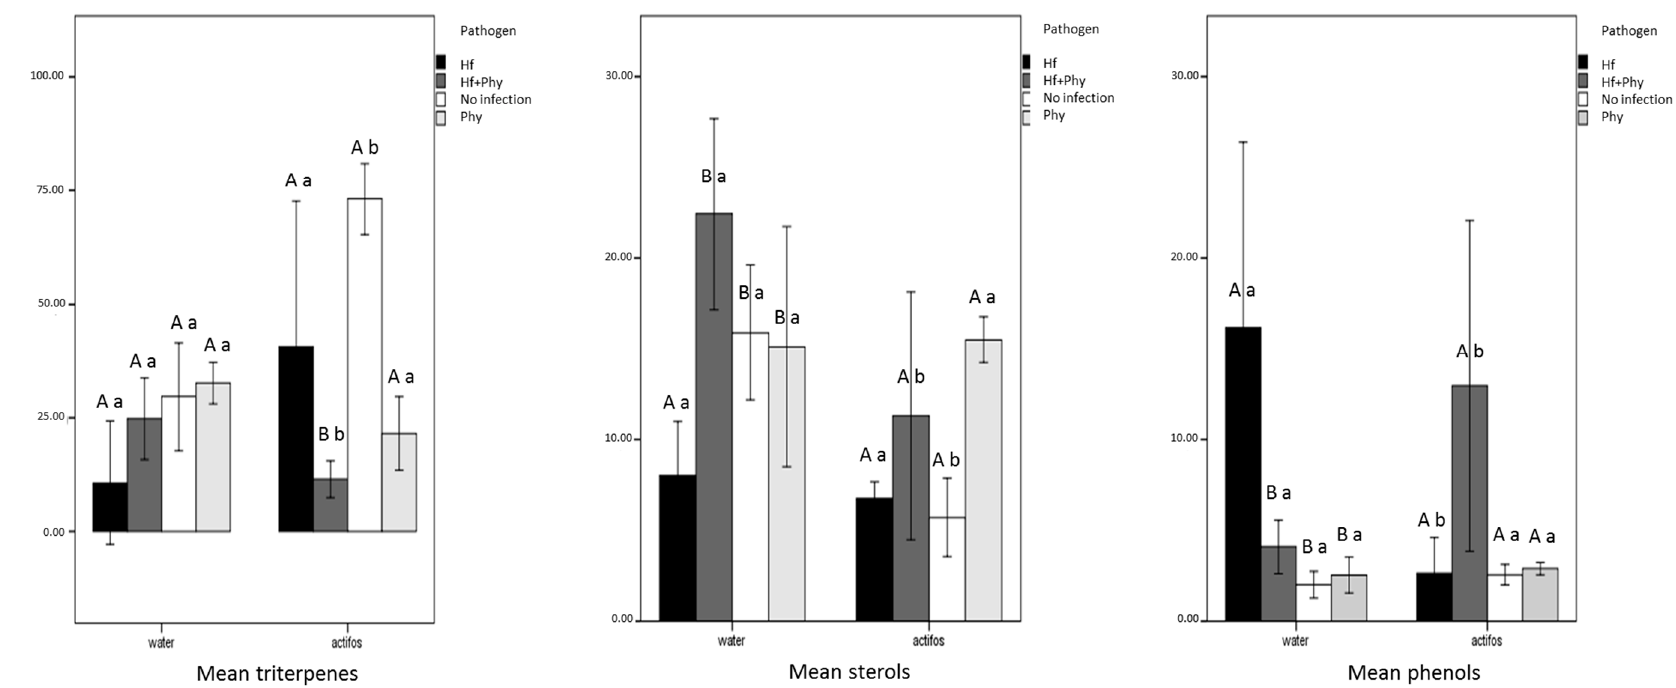
Figure 4. Content (%) of triterpenes, sterols, and phenols of cortical tissue samples of F. excelsior seedlings subjected to ammonium phosphite treatment (water and Actifos) after control, Hf, Phy, Hf + Phy infection. Uppercase letters indicate significant differences ( p < 0.05 Kruskal–Wallis and Mann–Whitney U -test) between mock-inoculated and fungal inoculated plants within the same treatment (water and Actifos). Lowercase letters indicate significant differences ( p < 0.05 Mann–Whitney U -test) between plants subjected to different treatments and the same inoculation type.